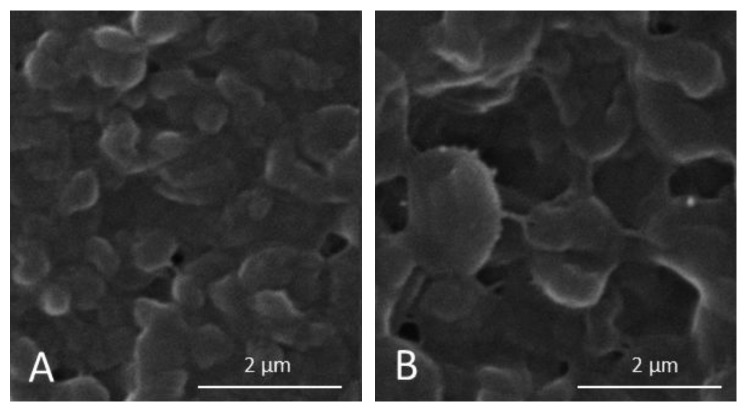
Morphology of mixed biofilm. The morphology of bacteria in the mixed biofilms visualized using the scanning electron microscope. Scale bar, 2 µm. Panel A corresponds to 48 h mixed biofilms and panel B corresponds to treated 48 h mixed biofilms. At least three random fields were observed and analyzed, from three independent experiments.